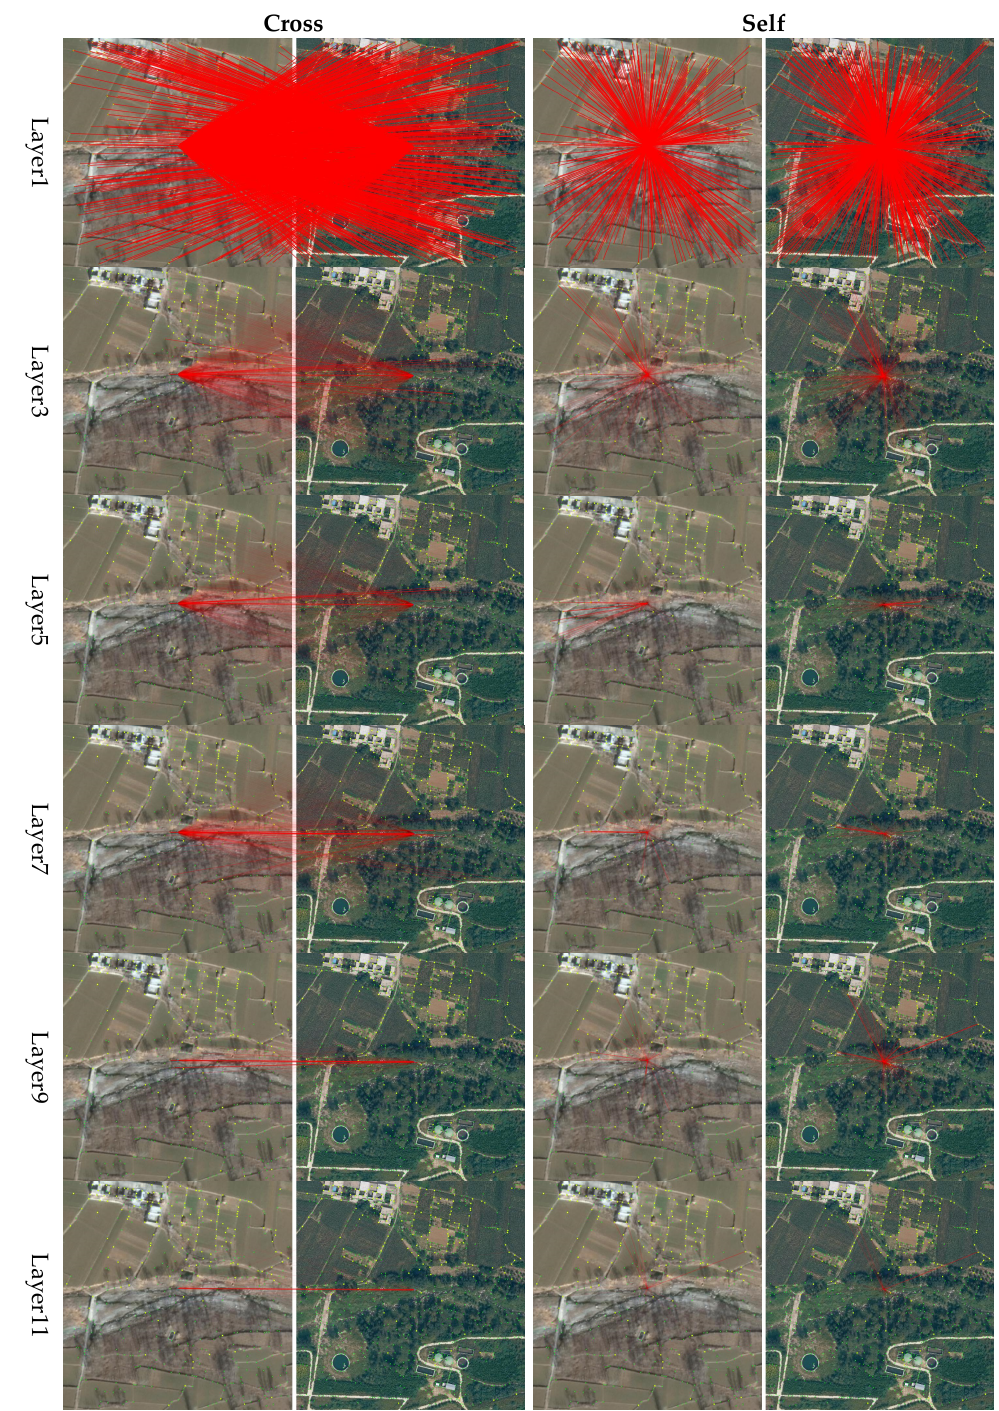
Figure 8. Visualization of the Attention mechanism. We visualize an odd number of Attention layers, with cross-Attention on the left and self-Attention on the right. The yellow point is the correct matching, the green point denotes the incorrect matching point, the red line is the Attention of the target point on other points, and the color’s depth indicates the Attention’s intensity.